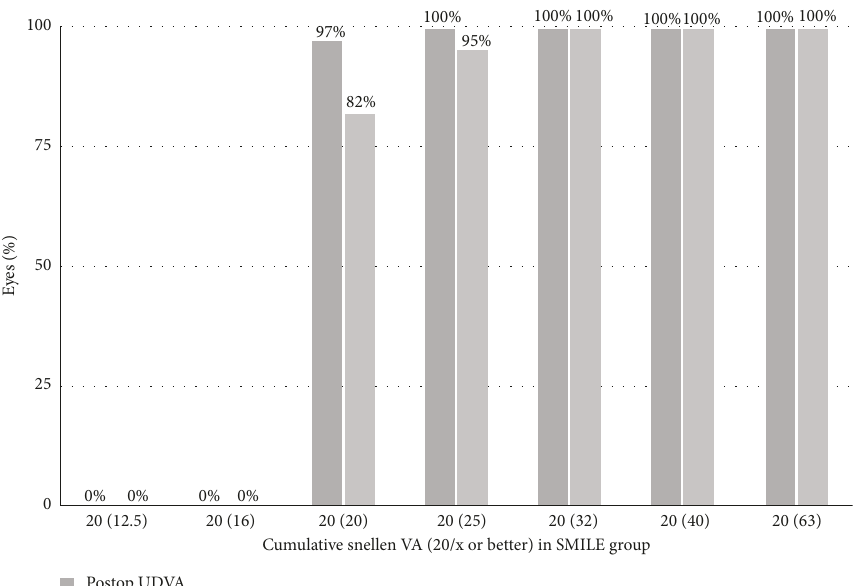
Figure 3: Cumulative Snellen visual acuity in SMILE group: preop CDVA and post UDVA.